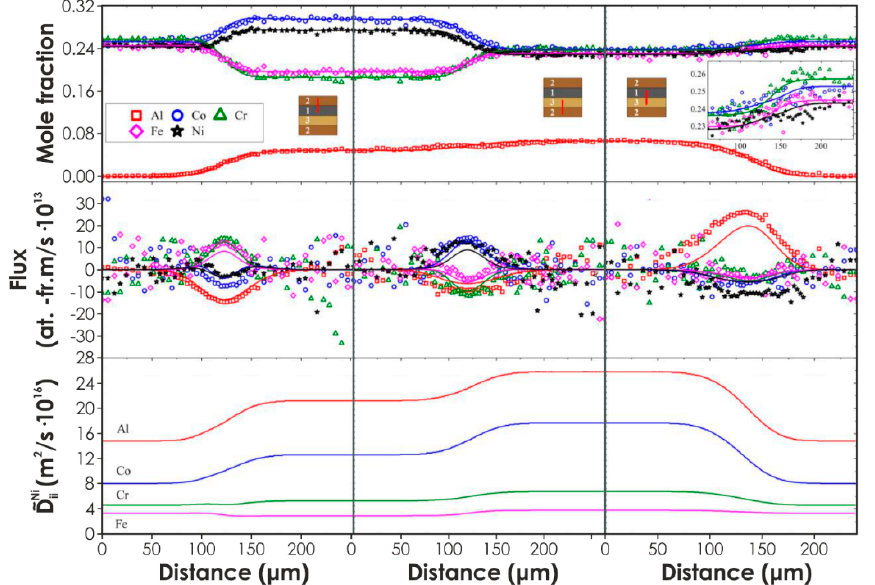
Figure 10. Comparison between the experimental and the simulated concentration profiles and interdiffusion fluxes in Al-Co-Cr-Fe-Ni diffusion couples annealed at 1323 K for 46 h, as well as the evaluated diagonal interdiffusivities (after [36]).